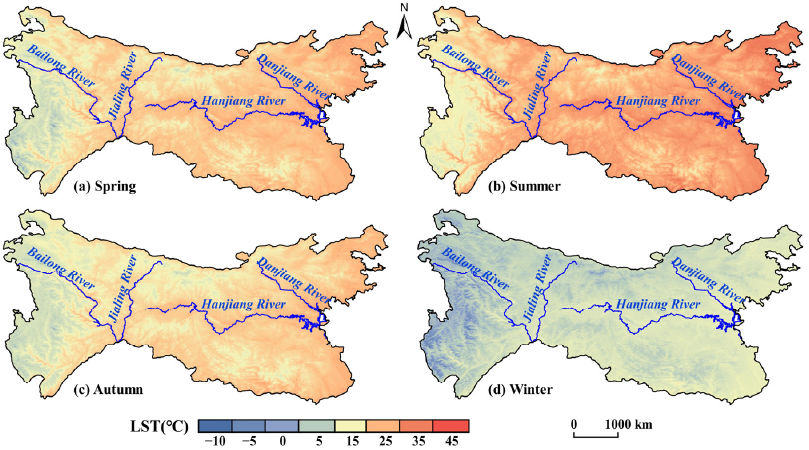
Figure 5. Spatial distribution of multiyear mean daytime and nighttime LST in spring ( a ); summer ( b ); autumn ( c ); and winter ( d ) in the Qinling-Daba Mountains from 2000 to 2020. Furthermore, we also found significant differences between seasonal LST variation trends in the Qinling-Daba Mountains (Figures 6 and 7). The LST change rate in the summer (0.102 °C·a − 1 ) was much higher than that of other seasonal and interannual LSTs, and 78.8% of the study area showed a warming trend, which was particularly pronounced in the Hanjiang, Yinghe, and Shahe rivers. The LST change rate in the spring was the second highest (0.417 °C·a − 1 ), and the area with a greater variation in LST was the Danjiangkou Reservoir. The amplitude of LST variation in autumn was relatively small (0.013 °C·a − 1 ). This is due to the fact that with global warming, the delay of vegetation phenology and the extension of the growing season promote changes in vegetation greenness and slow down the upward trend of LST. The amplitude of LST variability in winter was essentially the same as that in autumn. Winter was dominated by cooling, with the largest amplitude of cooling recorded in the Taizishan Mountains. The winter LST reached its minimum in 2011, which may be the result of the strong East Asian winter monsoon and the La Niña influence of the winter Pacific.